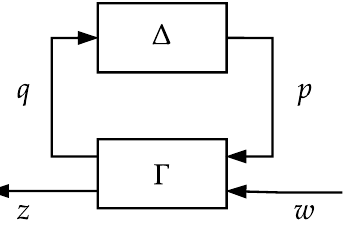
Figure 2. Standard feedback interconnection for robustness